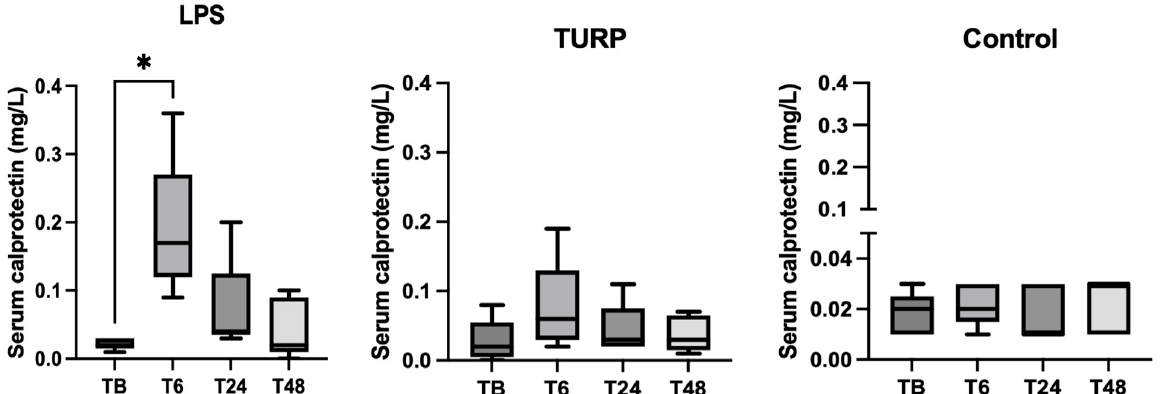
Figure 3. Changes in the serum calprotectin concentrations of pigs after lipopolysaccharide (LPS), turpentine (TURP) or saline (control) injection. The plots show medians (line within box), 25th and 75th percentiles (boxes) and min and max values (whiskers). * p -value < 0.05.